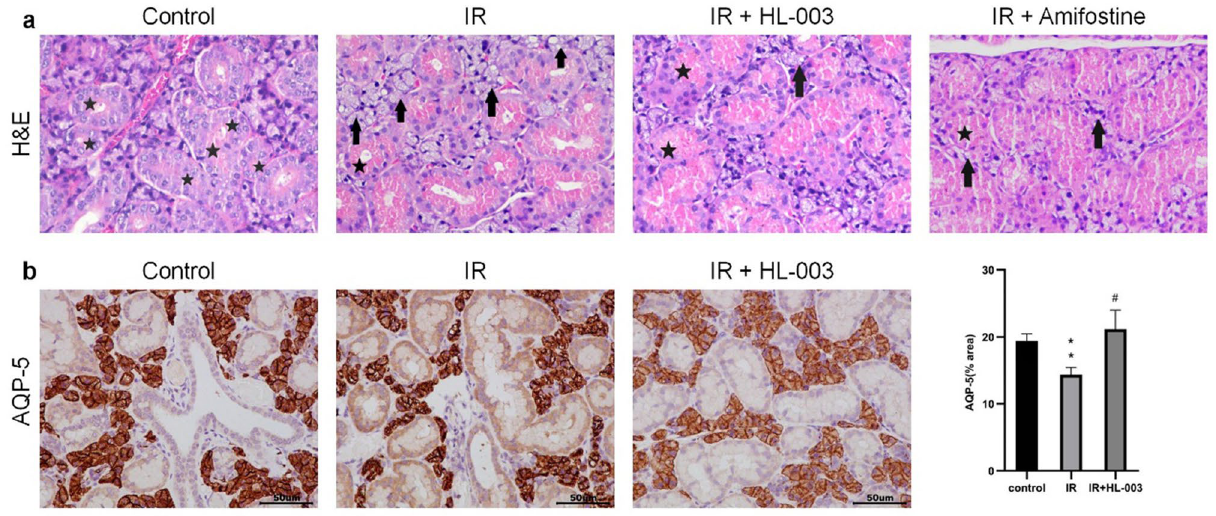
Figure 2. HL-003 alleviates damage of salivary glands. ( a ) Representative H&E staining of salivary gland structure. ★ , zymogen granule; → , vacuolization. ( b ) Representative immunohistochemical images show salivary epithelial cells (AQP-5 staining) in the salivary glands. Scale bars represent 50 μm. Each bar shows the mean ± SEM; **p < 0.01, compared with the control group; # p < 0.05, compared with the IR group (n = 6 per